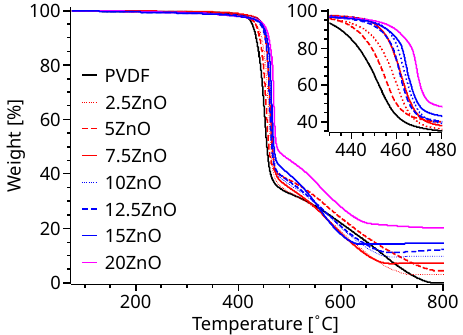
Figure 2. TGA measurements (inset shows a magnification in the area of interest). The glass transition temperature (Figure S1), measured using a differential scanning calorimetry, increased as a function of the percentage of ZnO content of the samples. In agreement with existing literature, smaller changes were noticed for samples with less than 7.5% of ZnO, which presented T g at − 40.1 °C and 30.9 °C for pristine PVDF and 7.5% of ZnO, respectively. 20% ZnO samples showed the highest T g at − 7.5 °C (Figure S1). The increasing T g can be explained by the lower molecular mobility of the PVDF chains induced by the ZnO nanoparticles’ and the crystallinity of ZnO